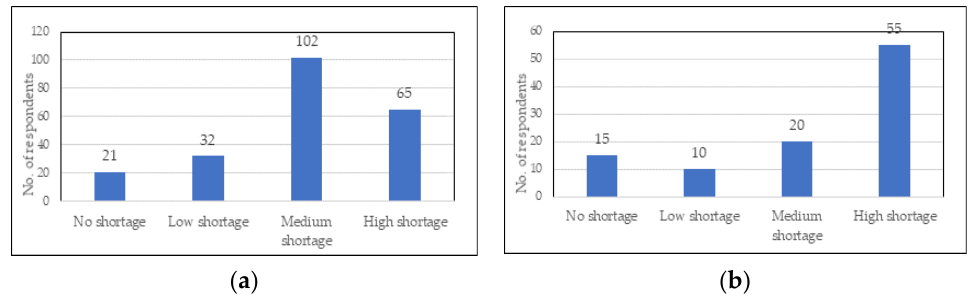
Figure 10. Adequacy of daily water provision: ( a ) Drinking water; ( b ) Irrigation water.